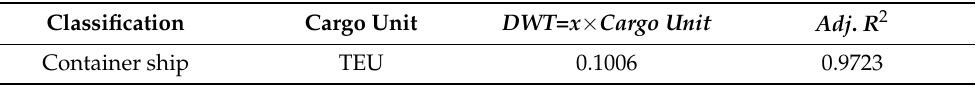
Table 5. Correlation analysis with deadweight tonnage (DWT) and twenty-foot equivalent unit (TEU) according to 75% coverage rate.